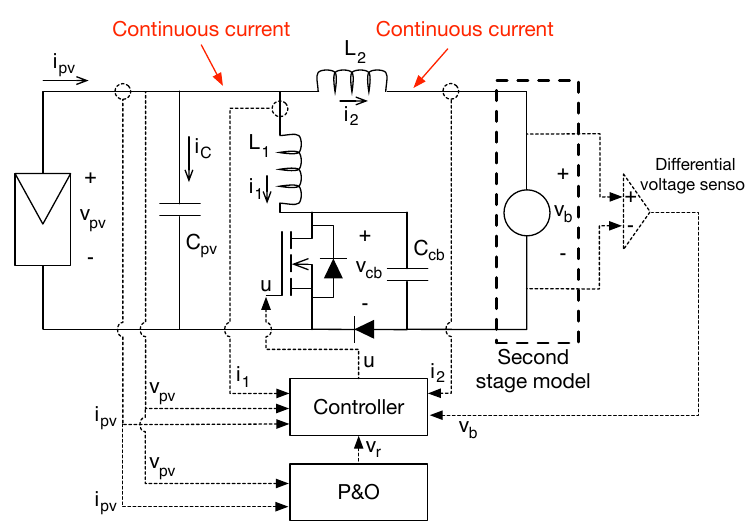
Figure 2. Circuital description of the PV system based on the NEC boost